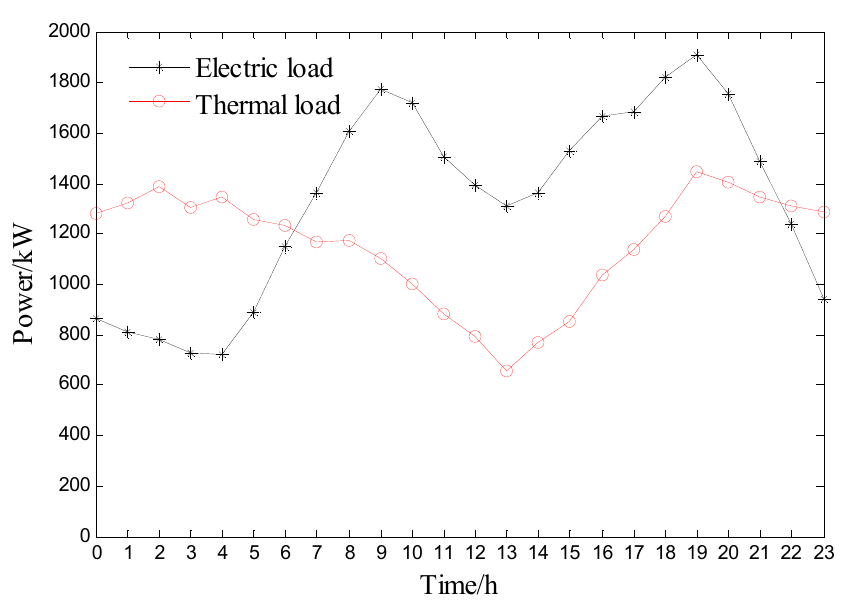
Figure 7. Typical daily thermoelectric load curve.